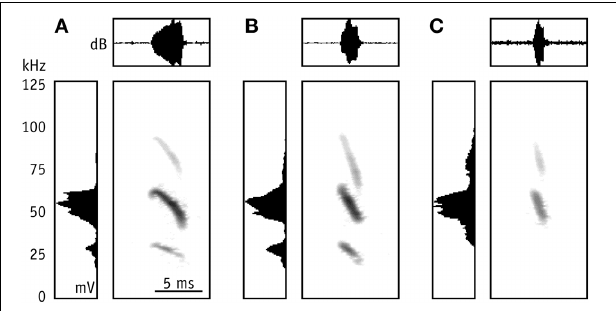
FIGURE 3 | Representative echolocation calls of M. macrophyllum foraging in the field above the water surface near the colony on BCI, Panamá. Sonogram (time versus frequency) with oscillogram (time versus amplitude [dB]) above and averaged power spectrum (mV) to the left; values have been normalized. (A) Search call; note the short shallow-modulated onset of the call; (B) approach call; (C) terminal phase call, emitted prior to capture of